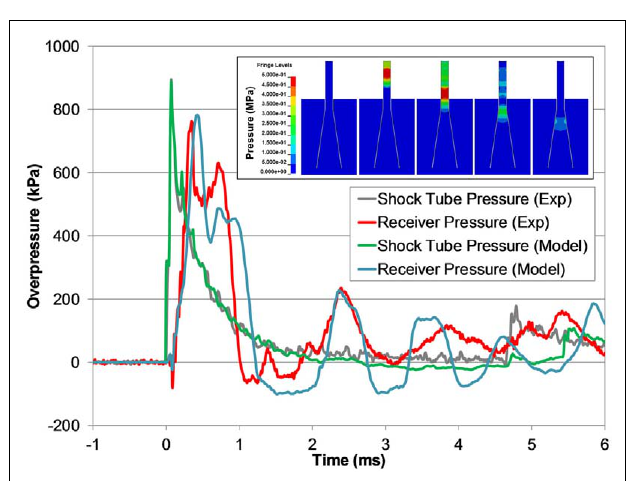
FIGURE 12 |Typical pressure and maximum principle strain traces of tissue calculated by the FE shock tube and receiver model (1300kPa burst). Predicted strain levels were much lower than the low strain-rate thresholds for function deficiency and axonal death (Bain and Meaney, 2000; Morrison III et al.,